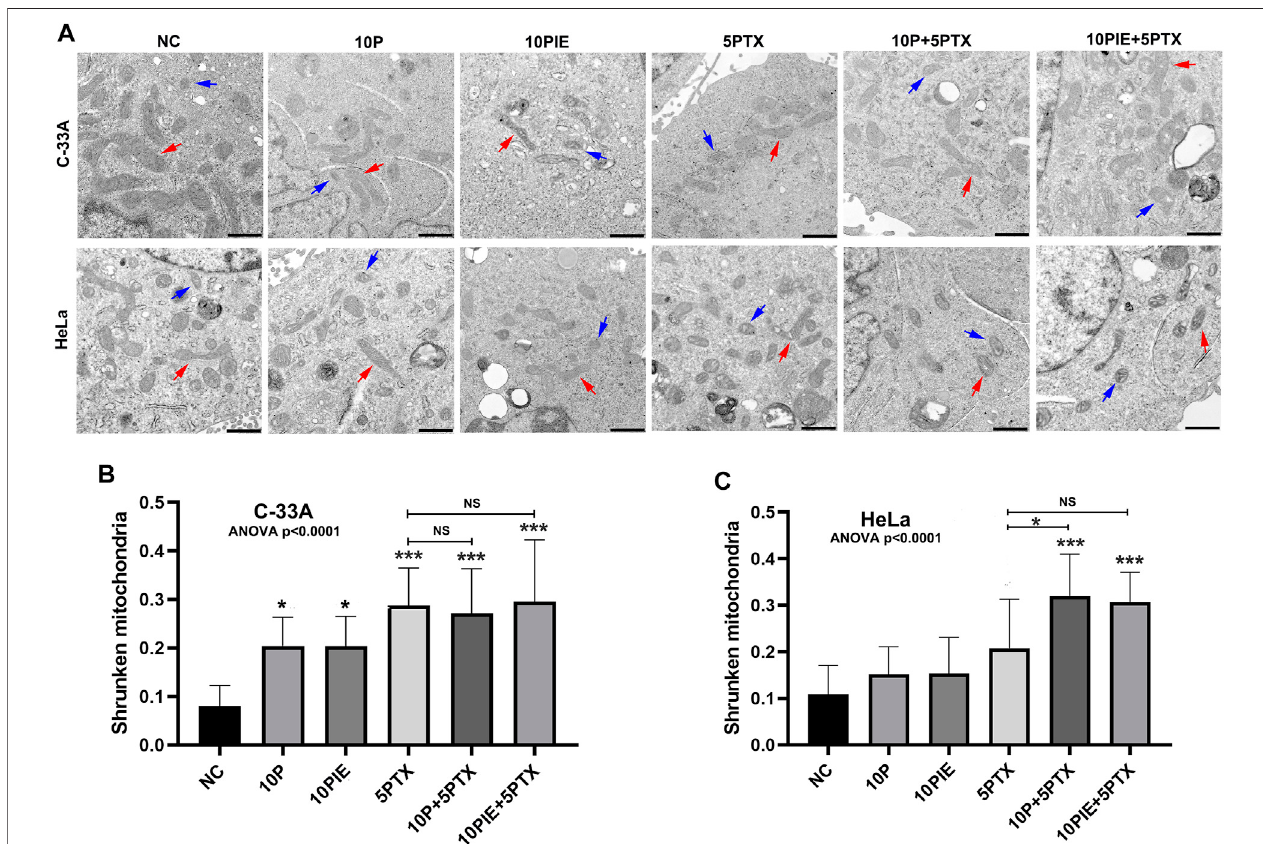
FIGURE 3 | Propofol/PIE induced and enhanced paclitaxel-induced ferroptosis-related mitochondrial morphological changes of C-33A and HeLa cells. (A) TEM assay was conducted to determine mitochondrial morphological changes of ferroptosis in C-33A and HeLa cells. Red arrows: typical mitochondria morphology. Blue arrows: shrunken mitochondria morphology. All the bars indicated 1 µm. (B,C) Statistical analysis of shrunken mitochondria percentage in C-33A and HeLa cells under different drug treatments. NS, no signi fi cant difference. * p < 0.05, *** p < 0.001.